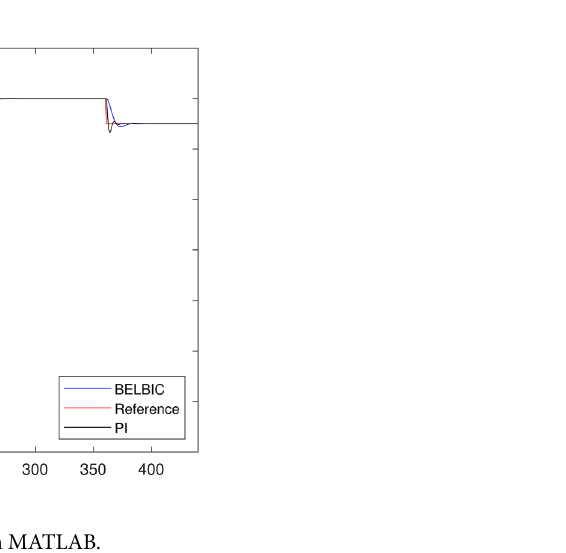
Figure 16. Flow rate control experiment in